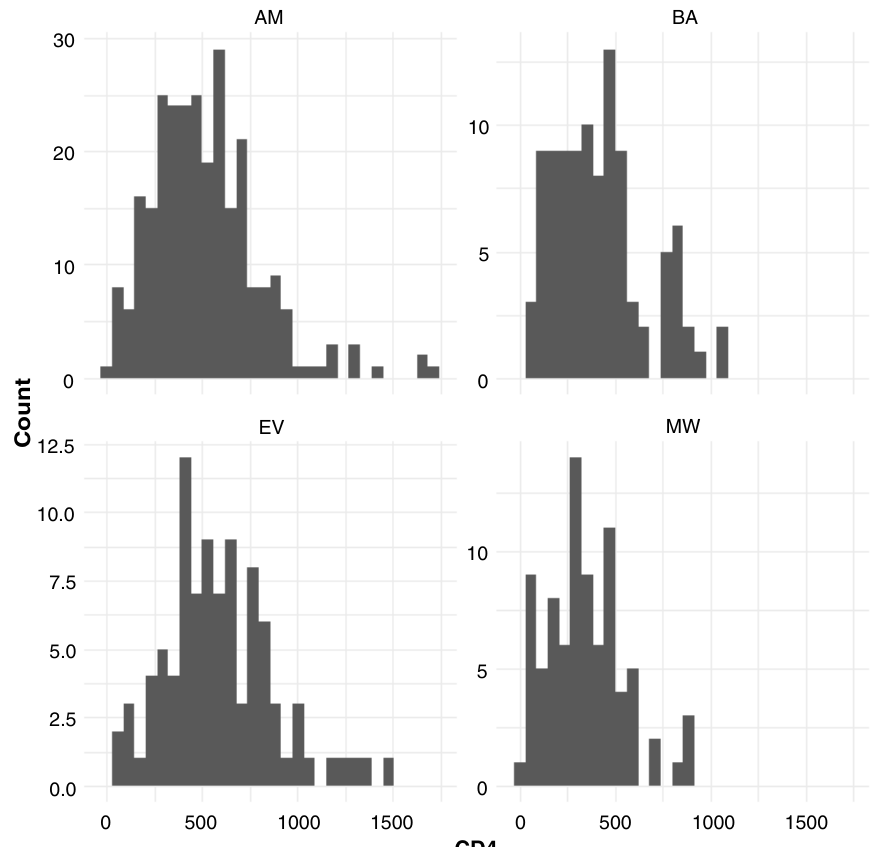
Figure 1. Distribution of CD4 counts in each of the four